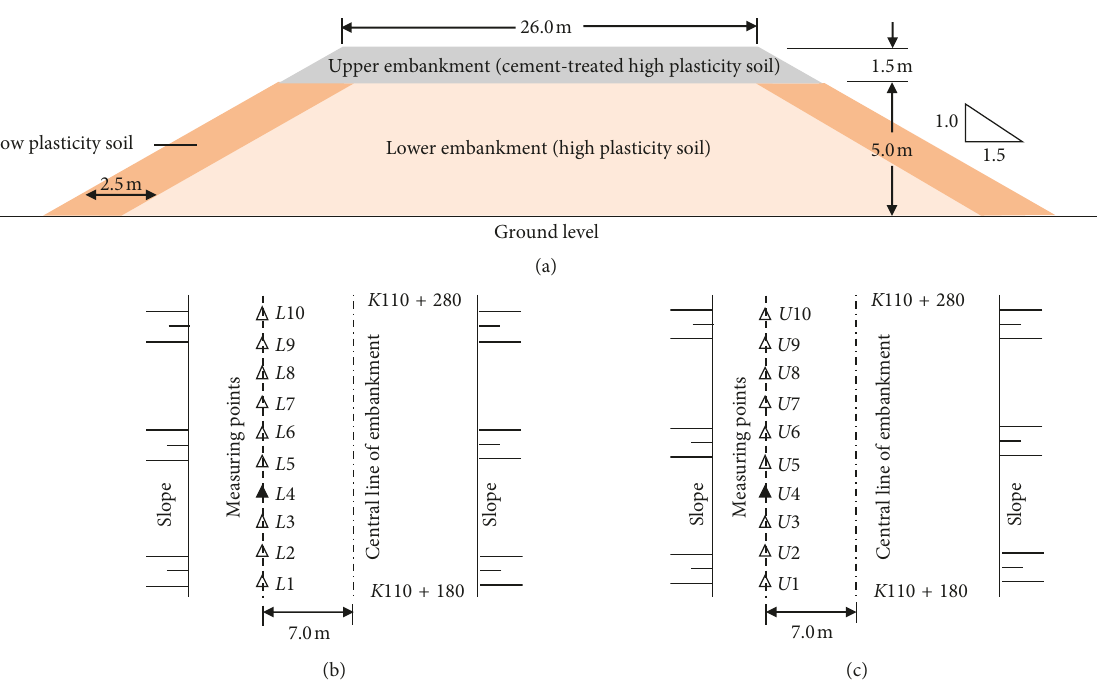
Figure 1: Embankment structure diagram and layout of measuring points. (a) Cross section of embankment. (b) Top of the lower embankment (elevation is 5.0m from the ground level). (c) Top of the upper embankment (elevation is 6.5m from the ground level).